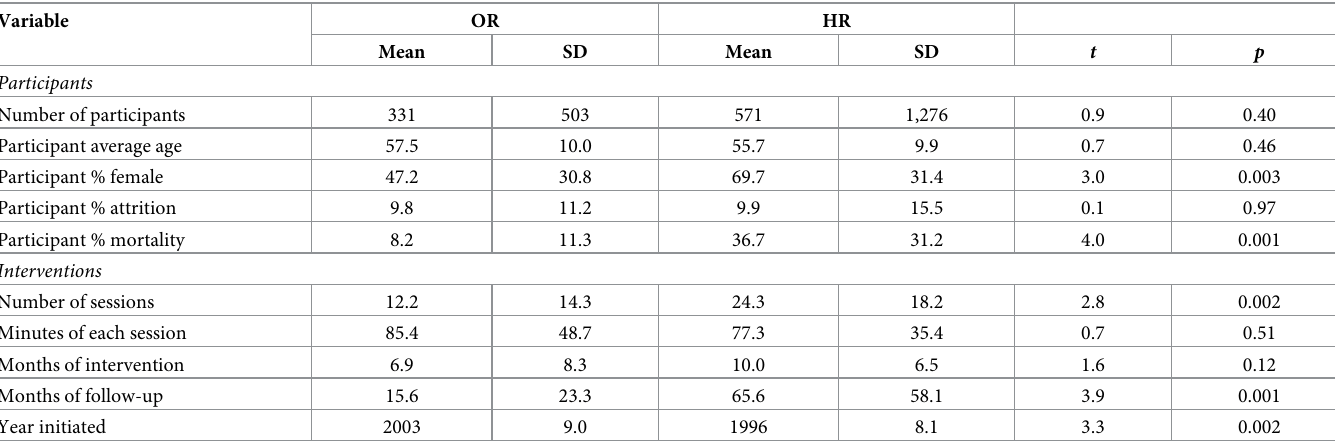
Table 1. Study characteristics by type of survival data